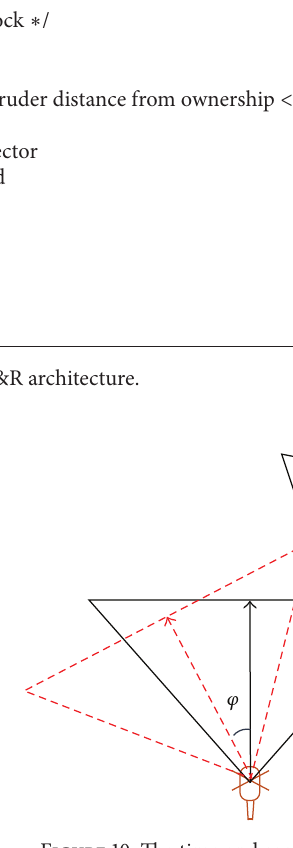
Figure 10: The time and sector recognition